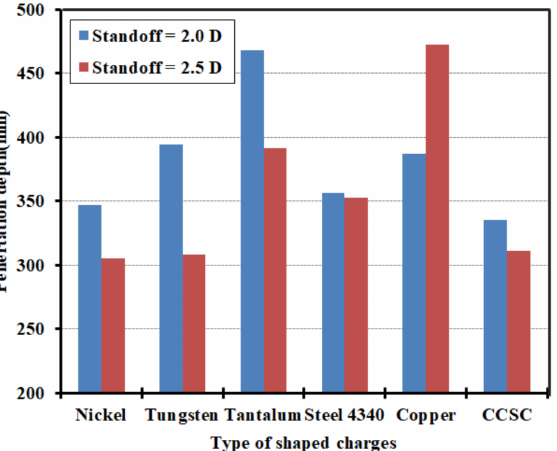
Figure 6. Penetration depths of shaped charges at 2.0 D and 2.5 D standoff distances (CCSC: classical conical-shaped